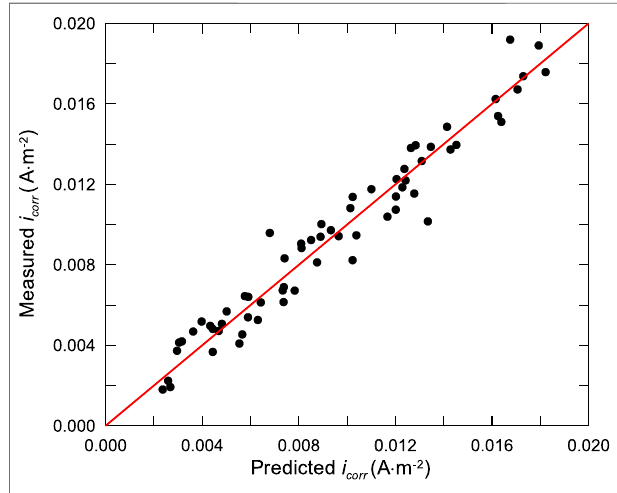
FIGURE 7 | The predicted and measured corrosion current